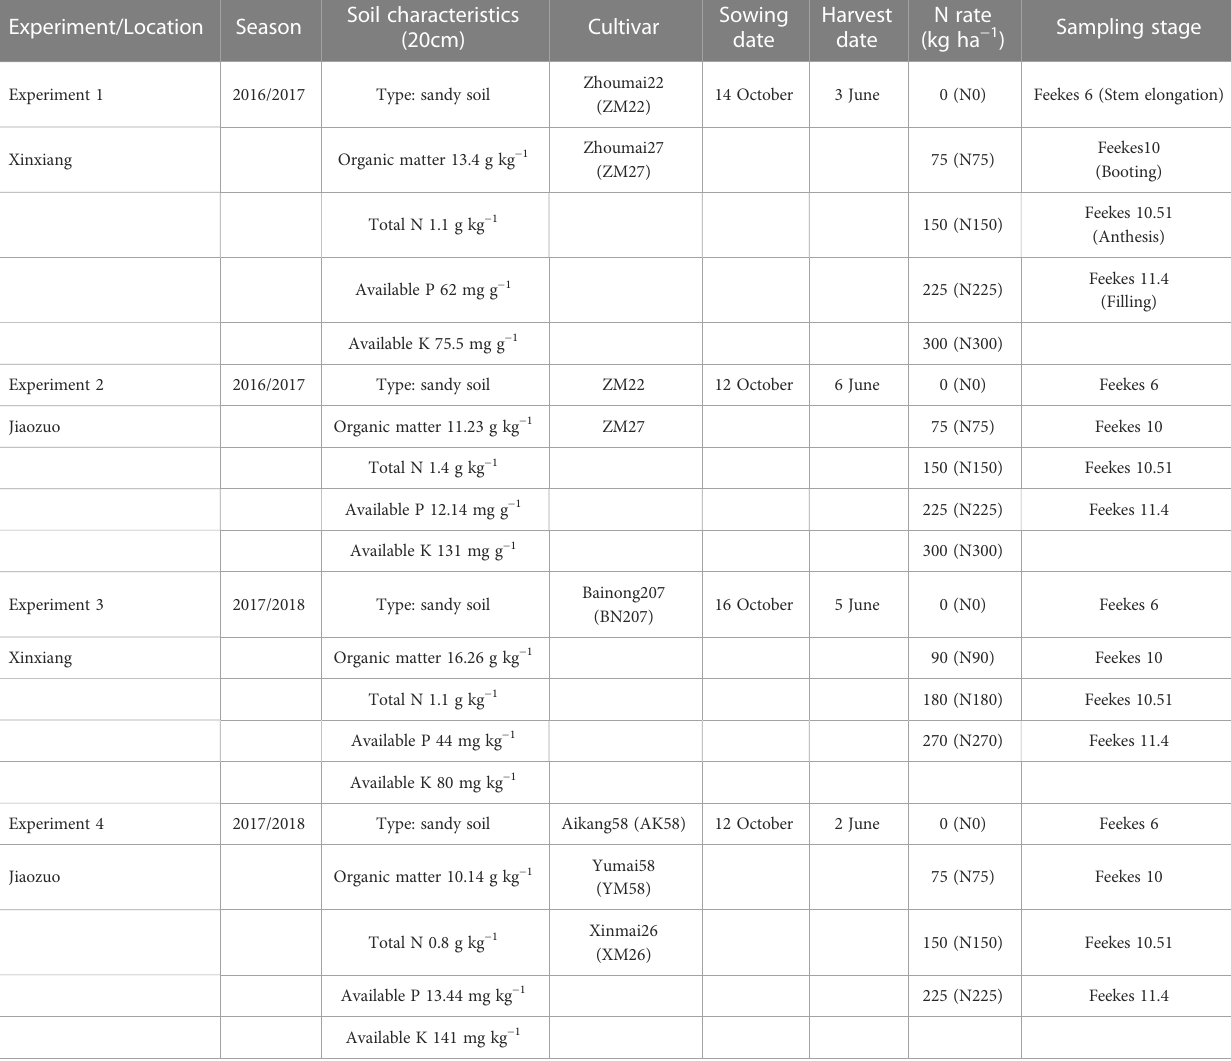
TABLE 1 Characteristics of the four fi eld experiments conducted in this study during 2016 – 2018.